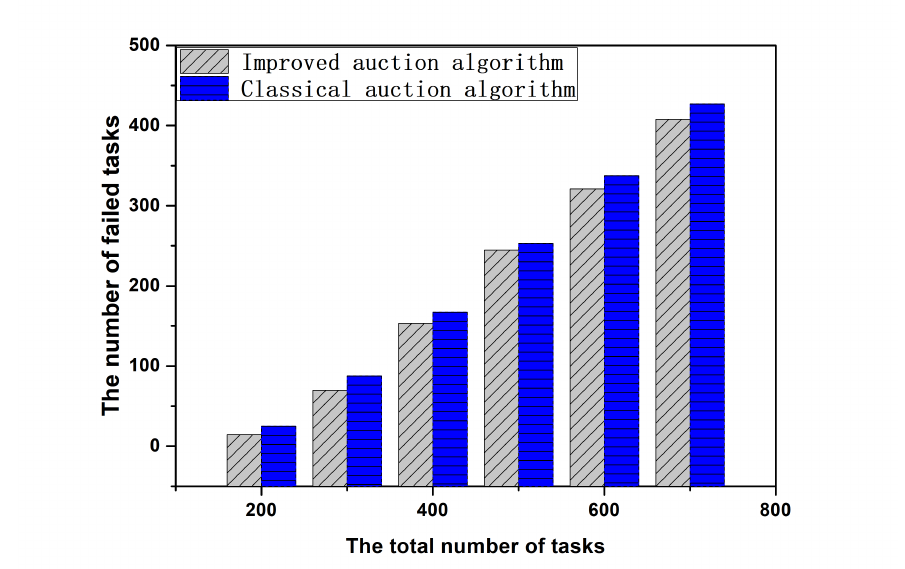
Figure 11. The number of failed tasks under the different total number of